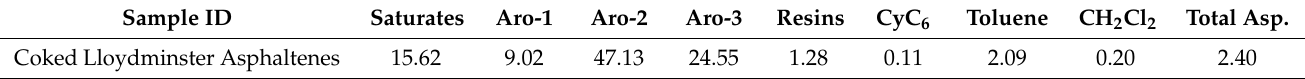
Figure 20. Plot showing the change in SAR-AD fraction from the pyrolysis of Lloydminster vacuum residue in Table 7. Table 7. SAR-AD data for liquids produced from Lloydminster asphaltenes after heating to 500 ◦